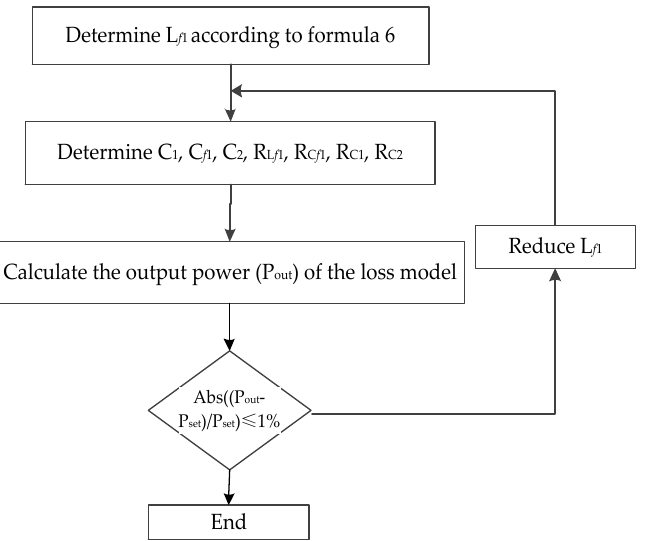
Figure 6. Flowchart of compensation parameters design.